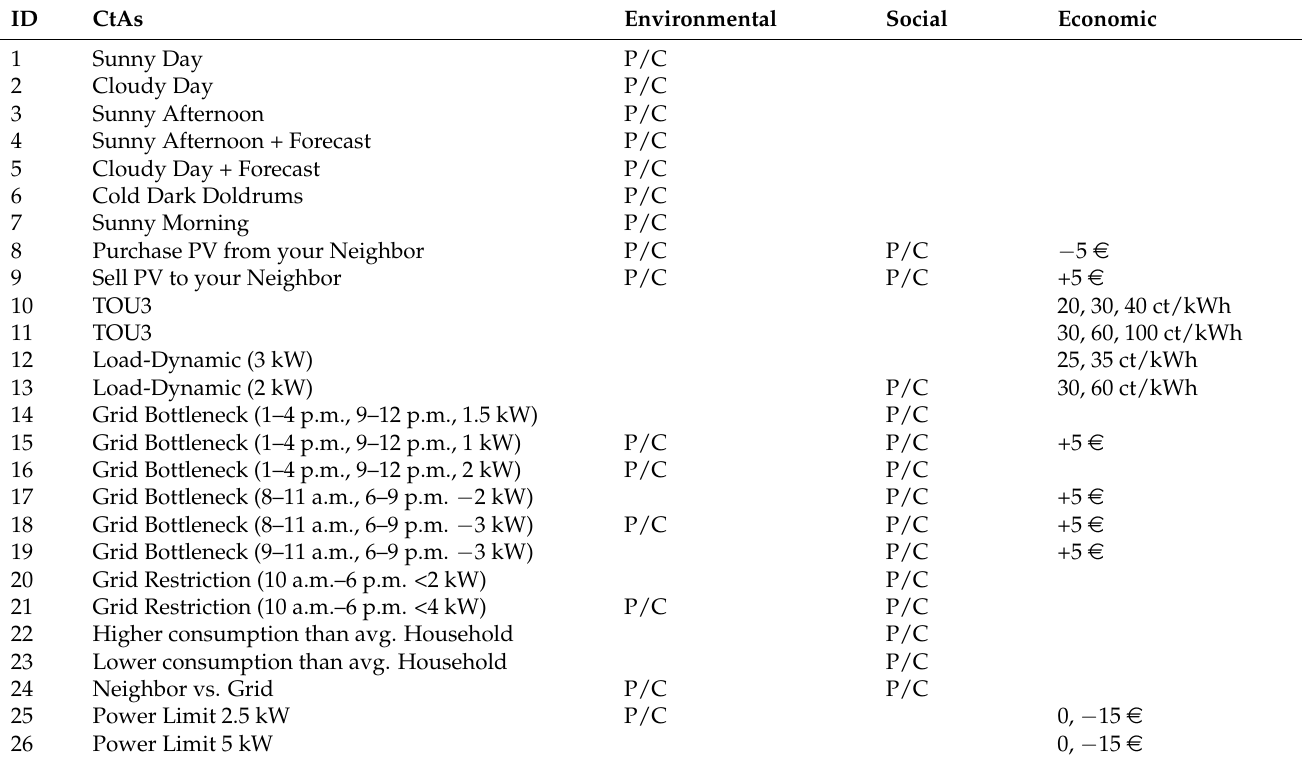
Table A1. Message per incentive category allocated to their respective CtA and incentives (P/C: Praise or Complaint). ID CtAs Environmental Social